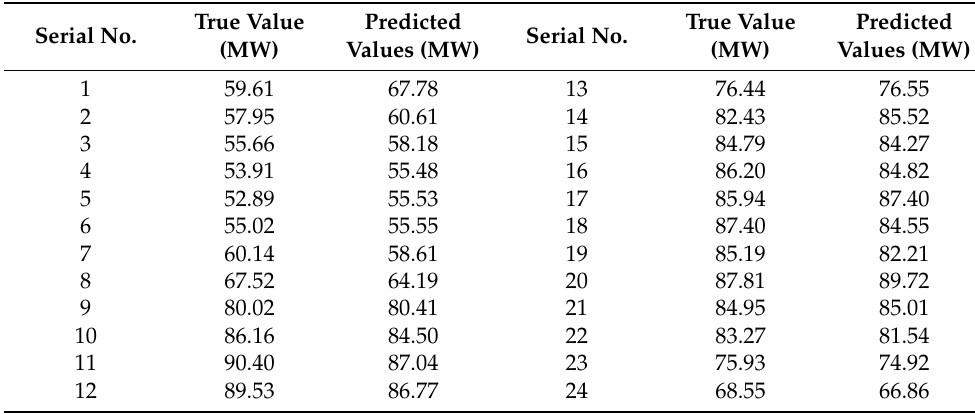
Table 3. Comparison of output values of LSTM model with real values. Serial